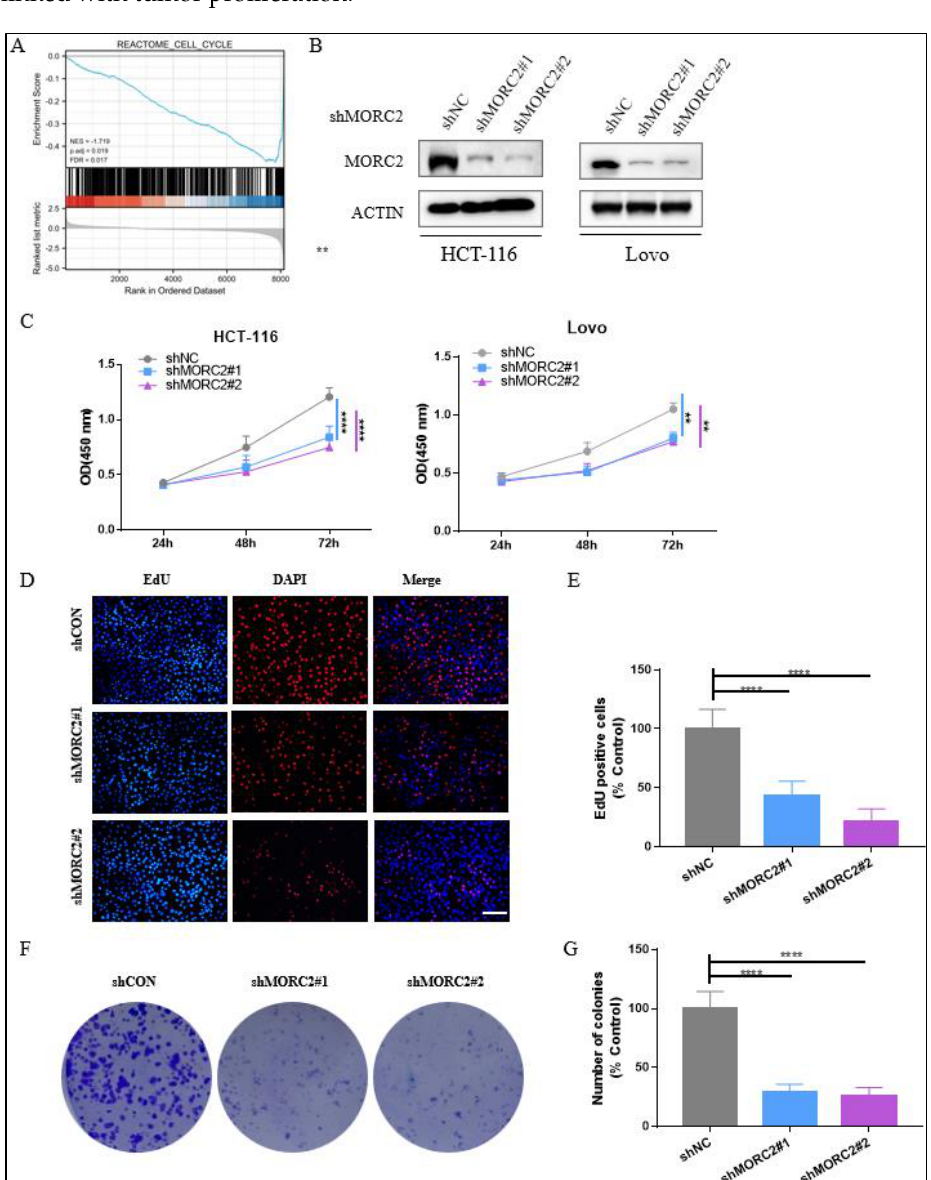
Figure 2. Knockdown of MORC2 inhibits HCT-116 and Lovo cell proliferation and clone formation. ( A ) GSEA indicates that MORC2-associated DEGs were enriched in the cell cycle. ( B ) HCT-116 and Lovo cells were transfected with indicated shRNA, and the protein expression was analyzed with indicated antibodies. ( C ) CCK8 assays were used to assess the DNA synthesis of shCON, shMORC2#1, and shMORC2#2 groups with HCT-116 and Lovo cells. ( D , E ) Edu assay was used to assess the DNA synthesis of shCON, shMORC2#1, and shMORC2#2 groups with HCT-116 cells. The percentage of EdU-positive cells in shCON, shMORC2#1, and shMORC2#2 groups. ( F ) Colony formation assay showing clone formation capacity of shCON, shMORC2#1, and shMORC2#2 groups. ( G ) Each group colony number was counted and relative colony numbers in shMORC2#1 and shMORC2#2 were compared to the shCON group. ** p < 0.01, **** p < 0.0001. To explore the impact of MORC2 on cell proliferation, we constructed stable MORC2 shRNA-MORC2 (shMORC2)-expressing HCT-116 and Lovo cell lines, using lentiviruses containing two altered shRNA sequences against MORC2. The protein expression of